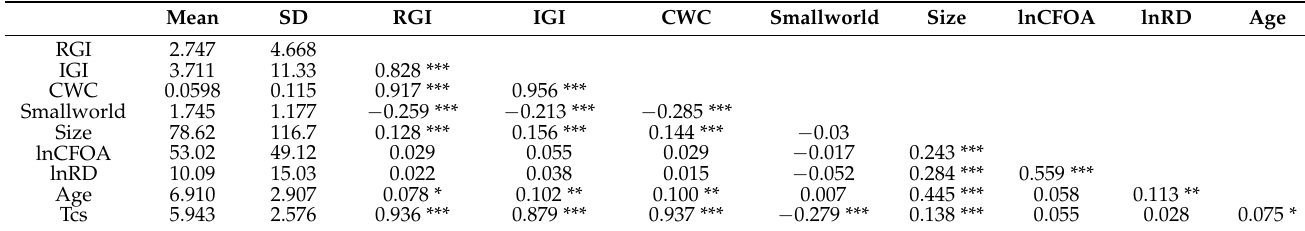
Table 2. Descriptive statistics and correlations.